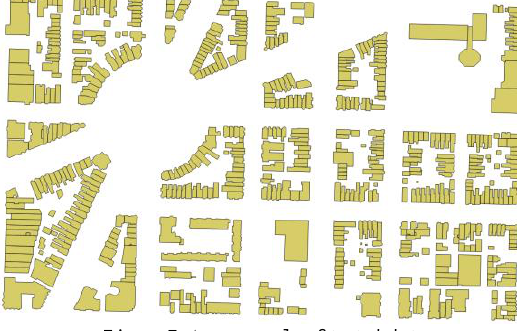
Figure 7. An example of tested